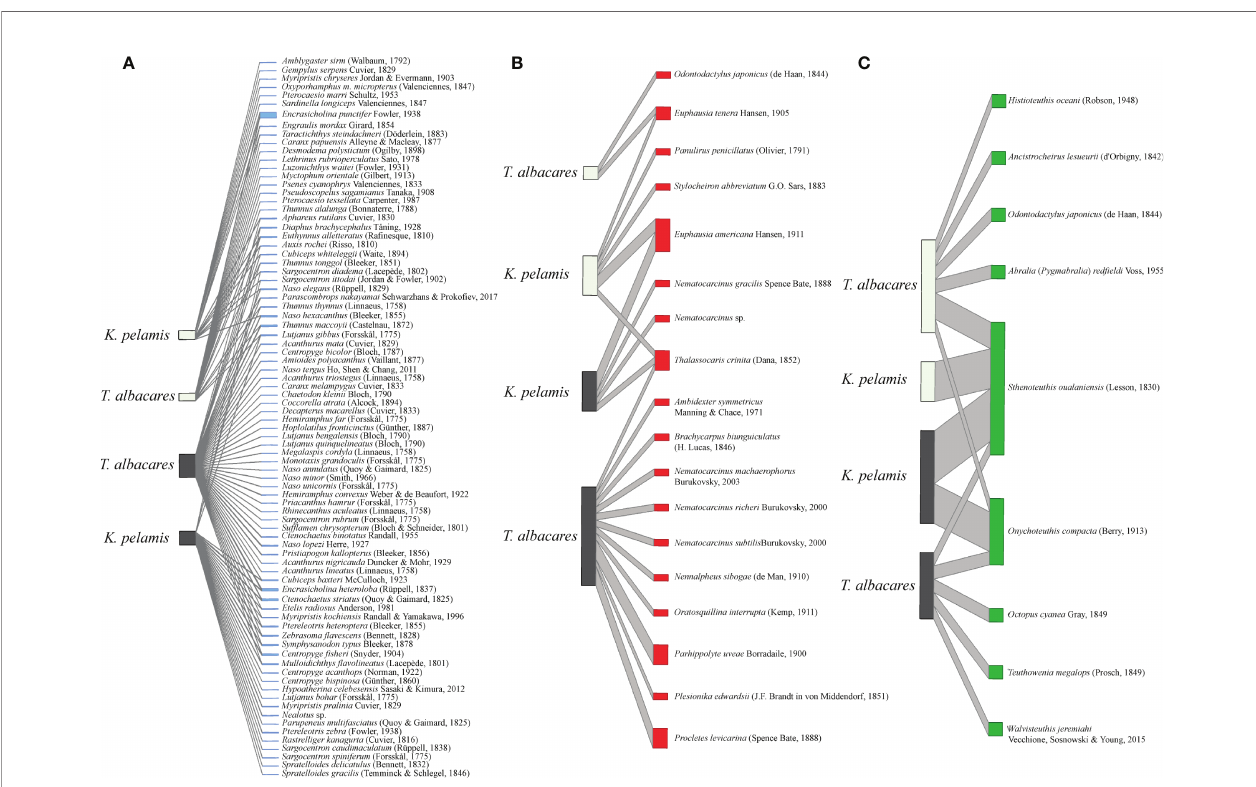
FIGURE 1 | Species-level comparison of Actinopterygii (A) , Crustacea (B) and Cephalopoda (C) prey species of Katsuwonus pelamis and Thunnus albacares captured during El Niño (dark grey) and La Niña (light grey) temperature oscillation events in 2015-2017. Operational Taxonomic Units (OTU) with less than 1,000 total reads were excluded from the ( Table 3 ). Model selection for crustacea only differed by a few AIC points for the top ranked models (<5 AIC points) demonstrating that model structure uncertainty was high.